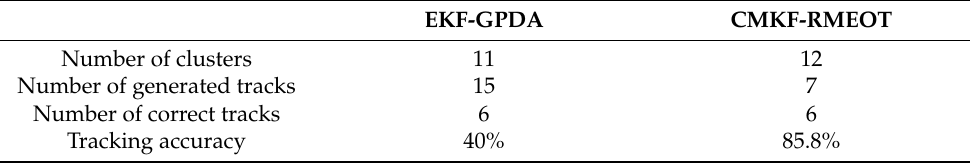
Table 2. Comparison of tracking results under point target and extended target tracking methods.